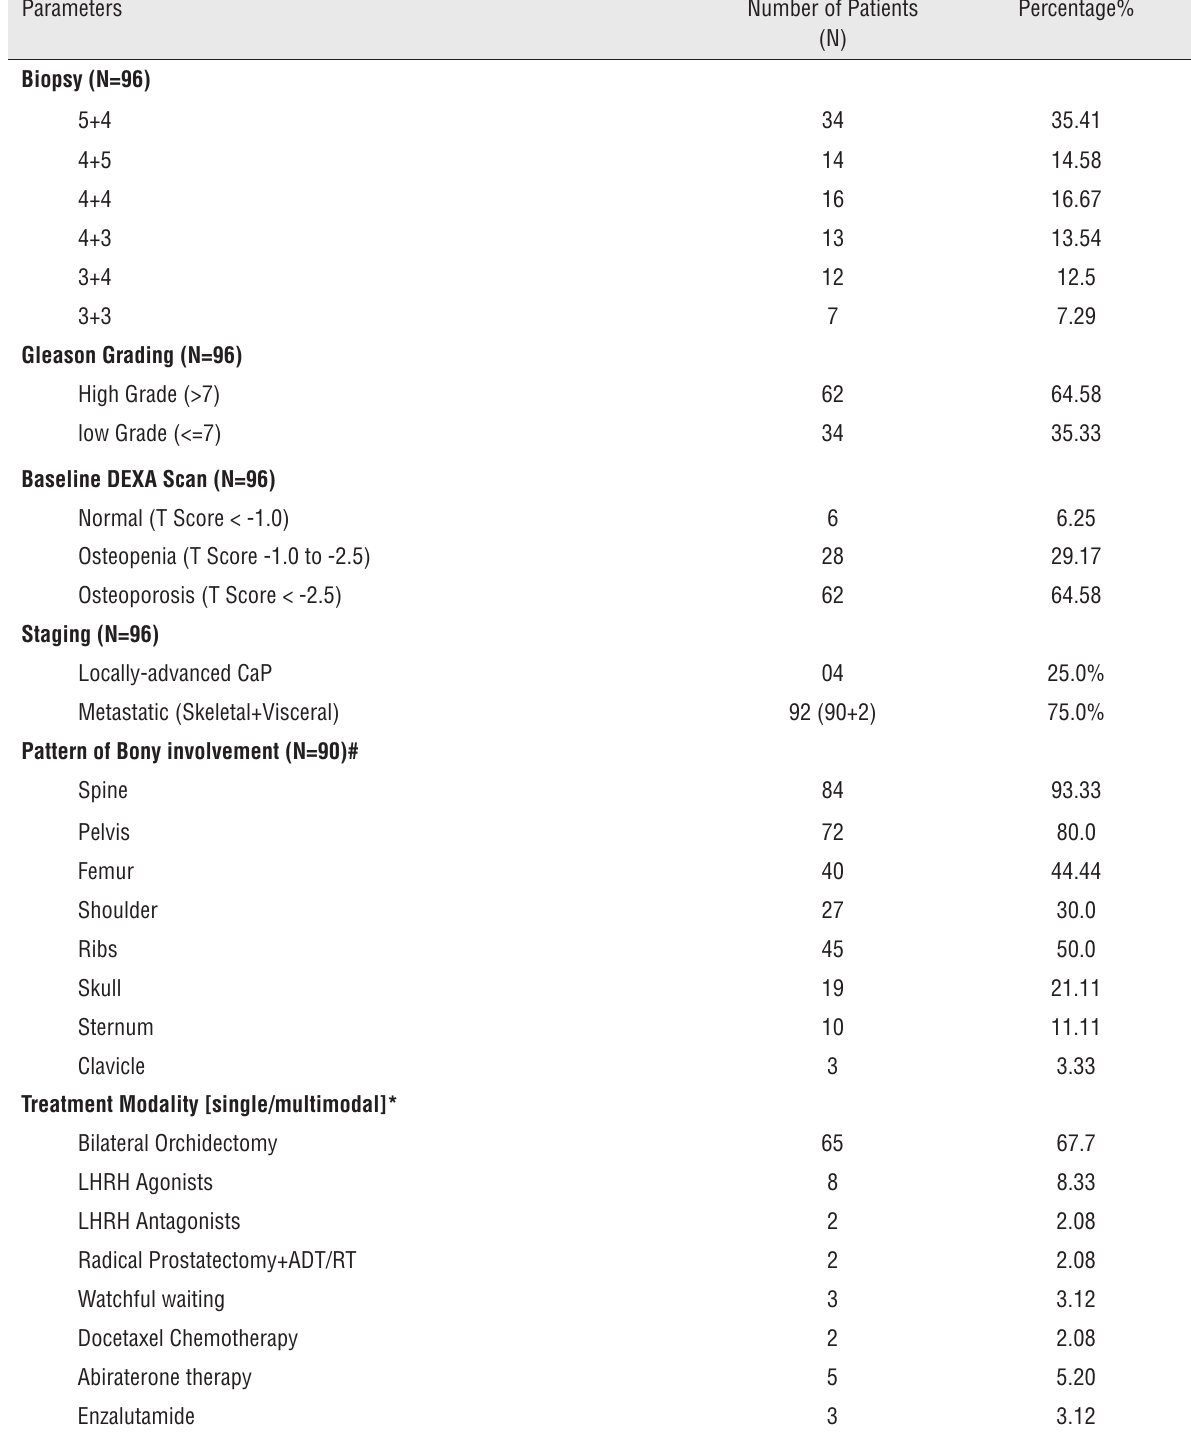
Table 2 - Description of radiological, pathological and therapeutic